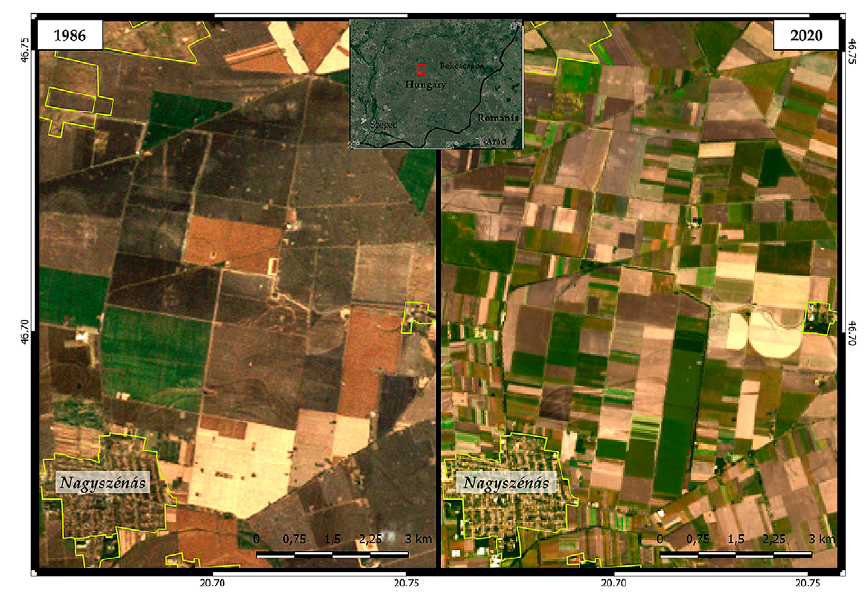
Figure 3. Parcel-level changes in an agricultural area, near Nagyszénás village.